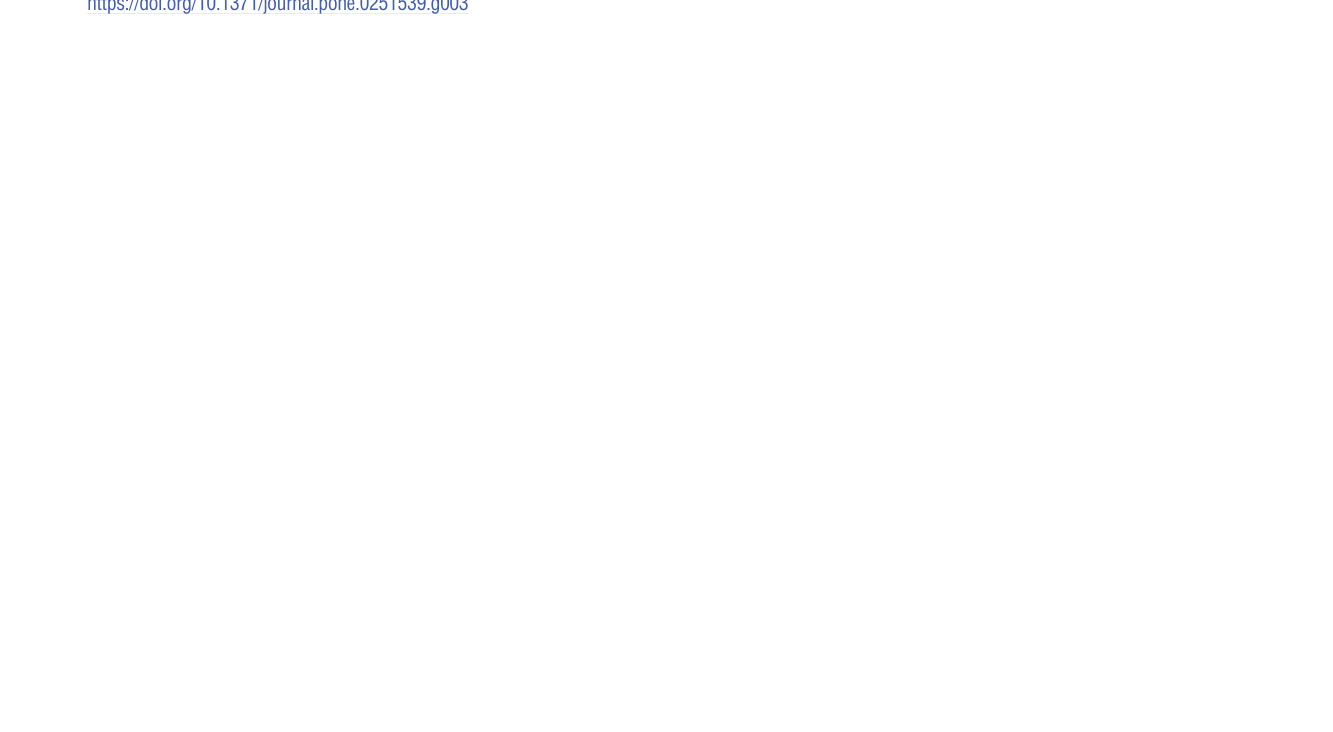
PLOS ONE | https://doi.org/10.1371/journal.pone.0251539 May 6,